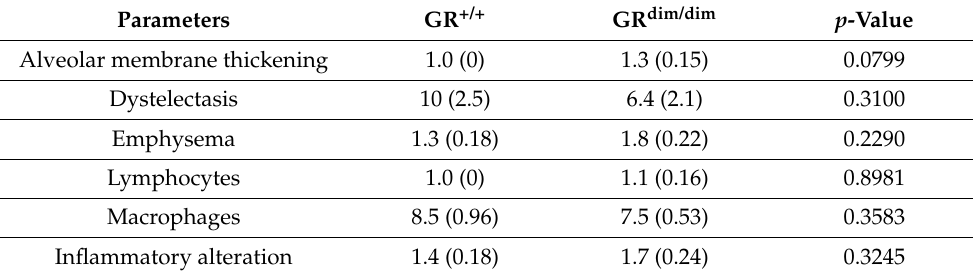
Table 1. Quantification of the pathological grading of lung sections from GR +/+ ( n = 7) and GR dim/dim ( n = 9) mice after HS with subsequent resuscitation. Data are shown as mean (SEM). Parameters GR +/+ GR dim/dim p -Value Alveolar membrane thickening 1.0 (0) 1.3